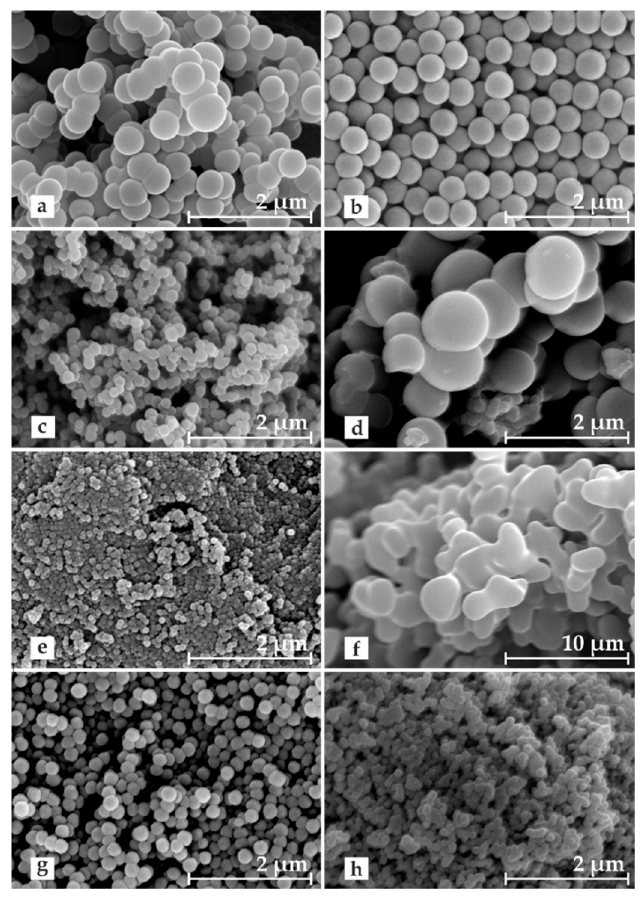
Figure 1. SEM pictures for carbonized resol resins: ( a ) 52_non, ( b ) 52_PVA, ( c ) 52_PVP, ( d ) 52_X100, ( e ) 52_P123, ( f ) 52_HCl, ( g ) 61_PVA, and ( h ) 131_PVA.